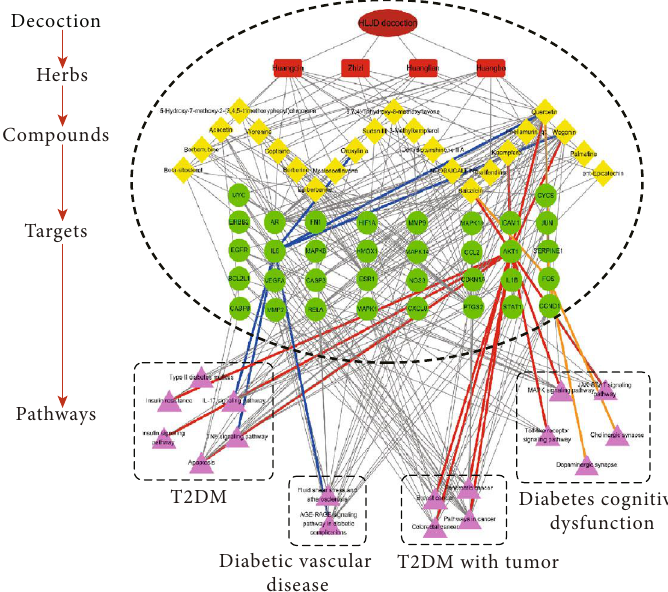
Figure 10: Decoction – compound – target – pathway network (Crimson indicates the HLJD decoction; red indicates the herbs; yellow indicates the compounds; green indicates the key targets; purple indicates the